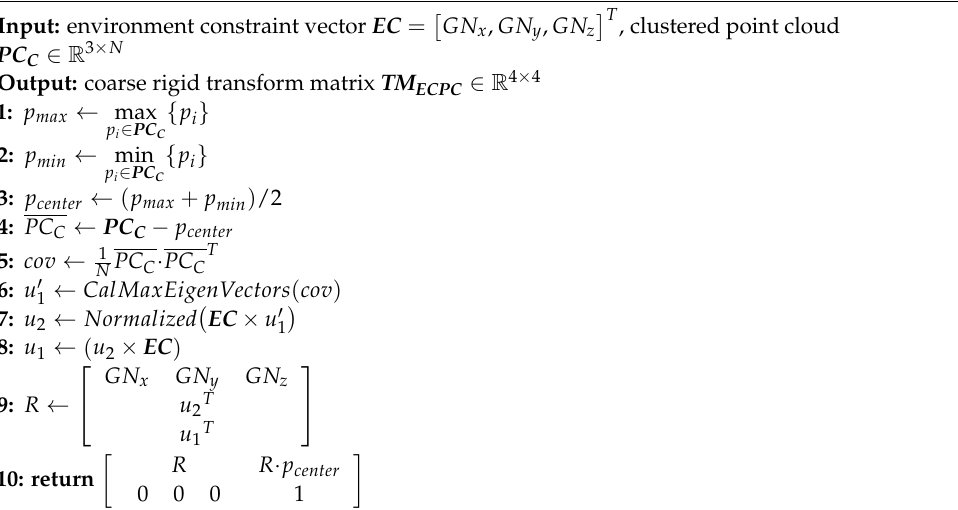
Algorithm 1 ECPC Initial Pose